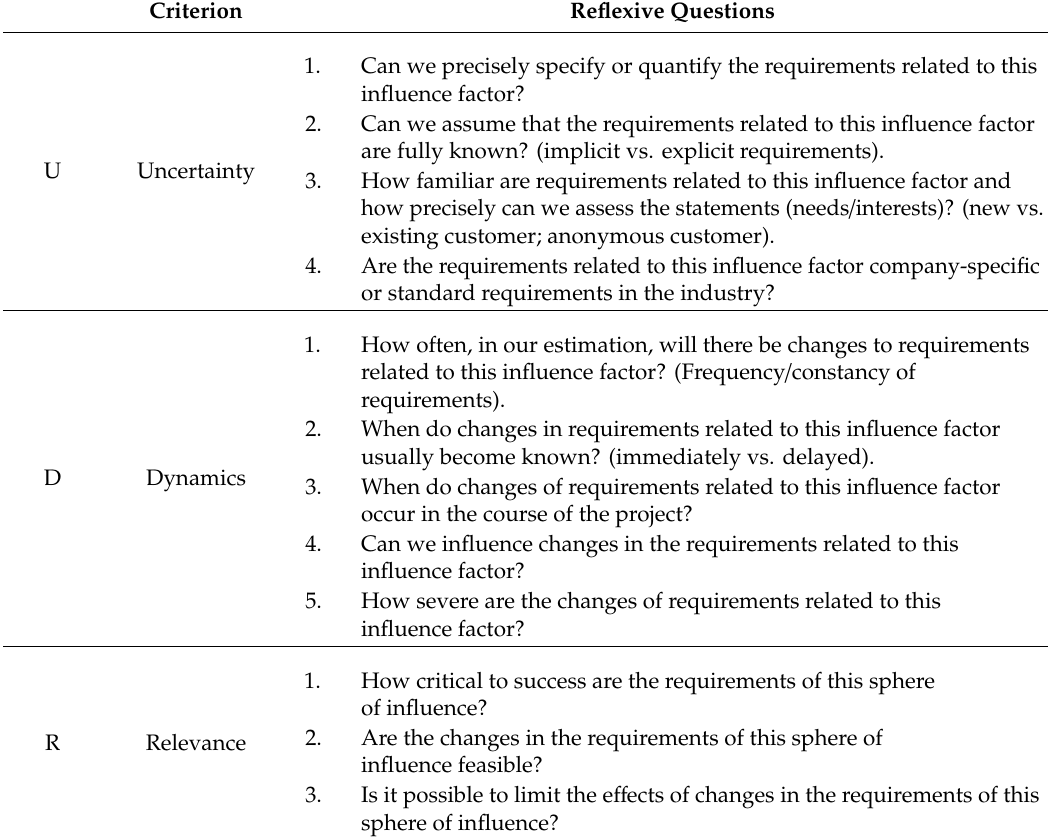
Table 3. Reflexive